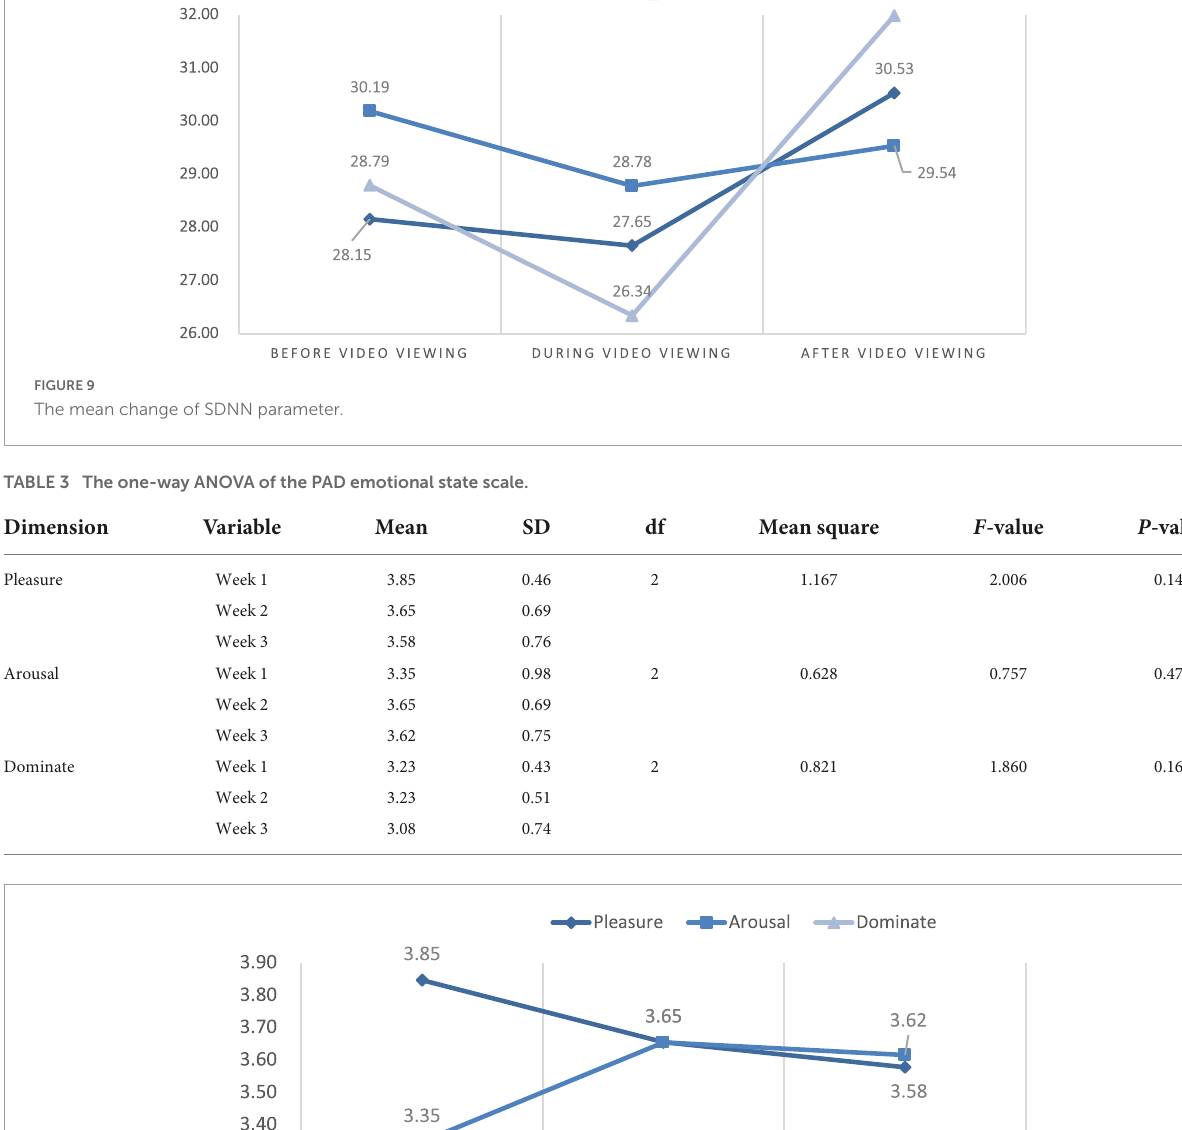
FIGURE10 The change of pleasure-arousal-dominance (PAD) emotional status scale in 3 weeks.